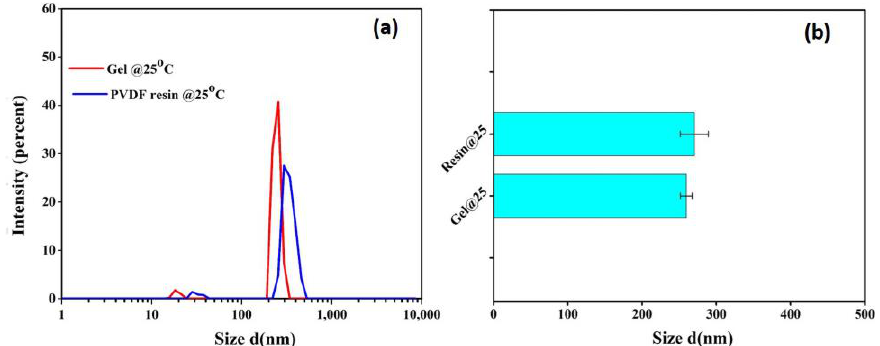
Figure 6. (a) Size distribution and (b) average size of microgels in dilute solution of PVDF resin and gel powders at 25 